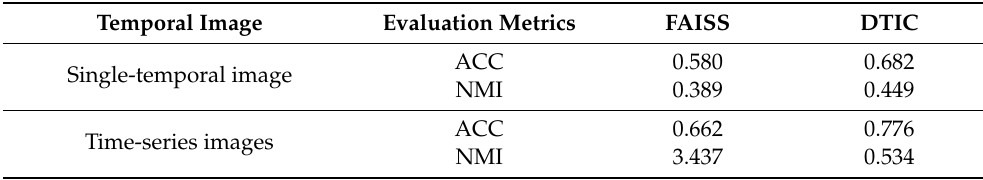
Table 8. The clustering accuracy of the comparison experiment between a single-temporal image and multi-temporal images on the Reunion Island